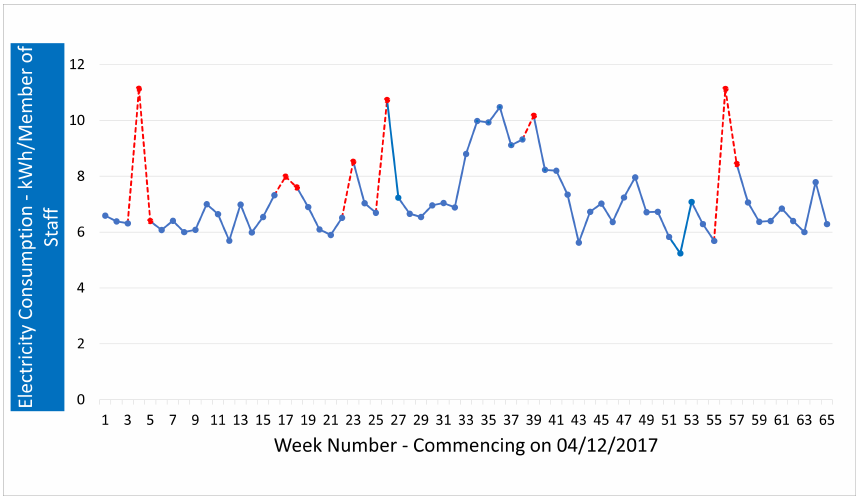
Figure 3. Electricity consumption per member of staff in the clinical engineering